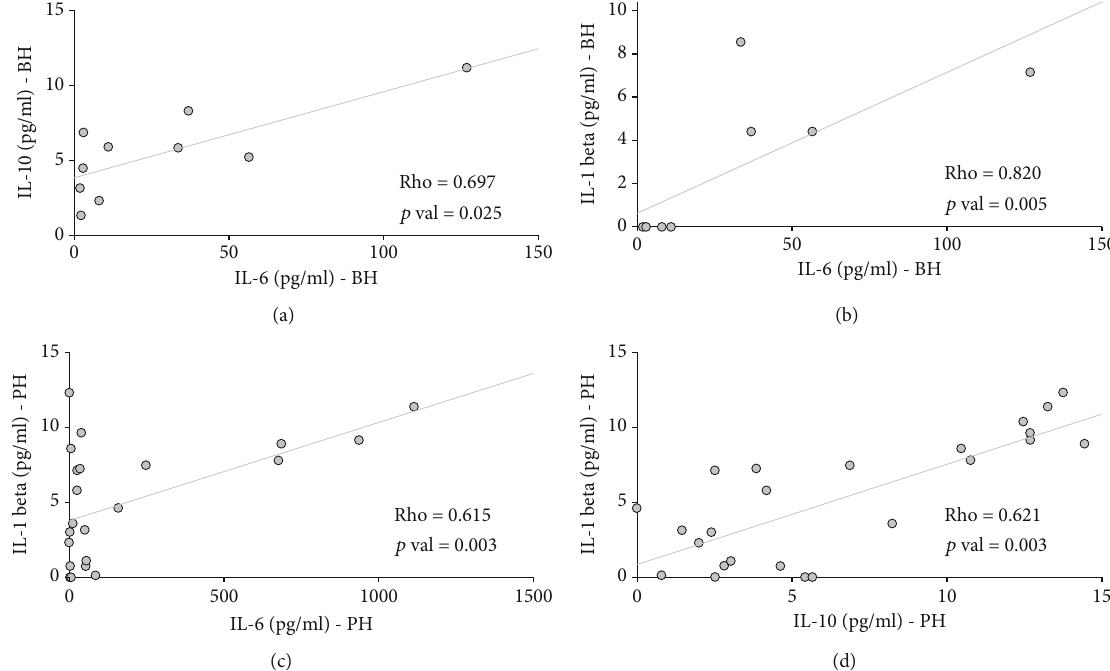
Figure 2: Correlation between cytokines in the synovial fl uid of knees with medial meniscal tears. (a, b) Illustrate the signi fi cant correlations in the group of BH tears, whereas (c, d) illustrate the signi fi cant correlations in the group of PH tears. Correlations among the cytokines were assessed for signi fi cance using the nonparametric Spearman rank correlation coe ffi cient test. A p < 0 : 05 was considered to be statistically signi fi cant. Calculated regression lines are